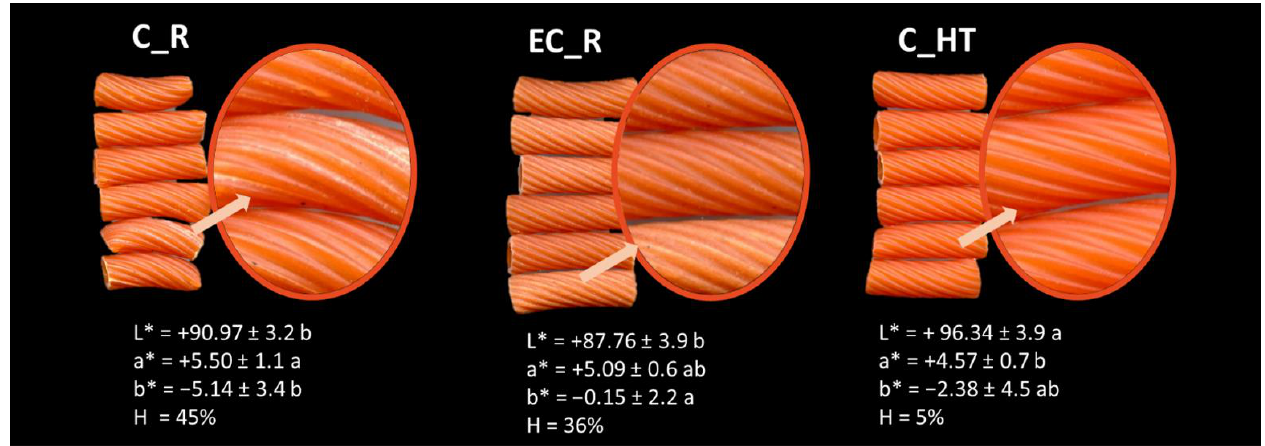
Figure 1. Images and surface characteristics of uncooked pasta from red lentils.